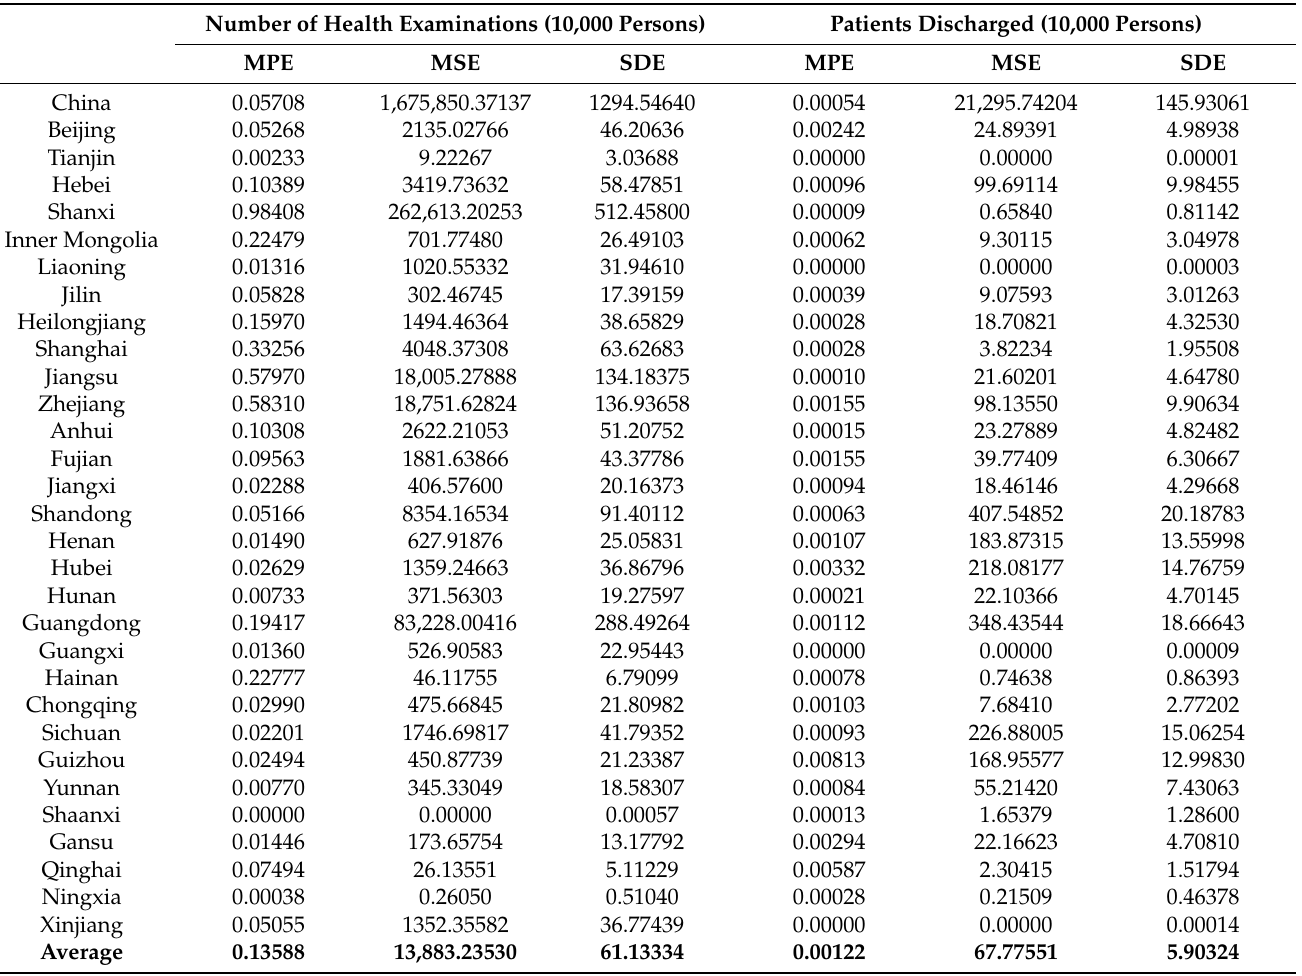
Table 4. The Second Part of Forecasting performance of LS-SVM-FM